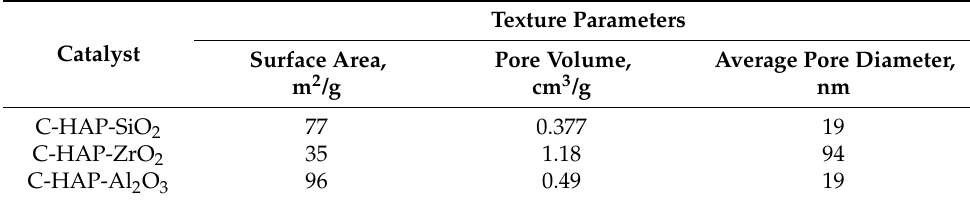
Table 2. Texture characteristics of C-HAP extrudates formed with different binders.